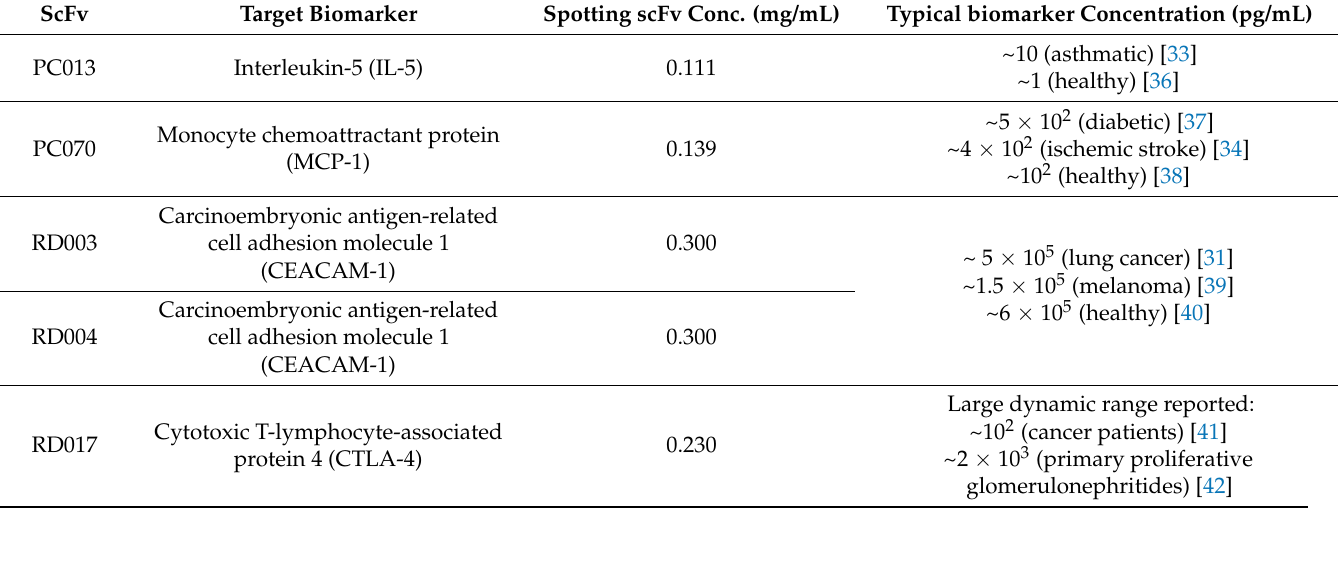
Table 1. Target and spotting concentration of single chain fragment variable (scFv), with typical biomarker concentrations in patients.